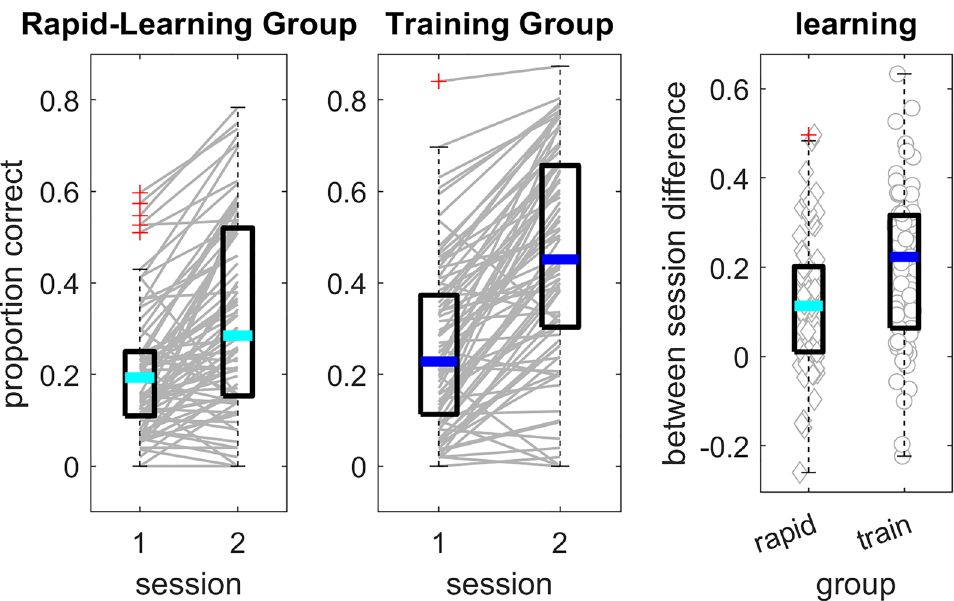
Figure 2. Time-compressed speech recognition and learning in the rapid-learning and training groups. The left and center panels show performance averaged within each participant in each session. Lines show data for individual participants. The rightmost panel show learning, expressed as the difference in recognition accuracy between the two sessions in the rapid-learning group (left) and in the training group (right). Background symbols denote individual data. The thick line within each boxplot shows group median; box edges mark the interquartile range; whiskers are 1.5 times the interquartile range; + signs are values outside the 1.5 × interquartile range.